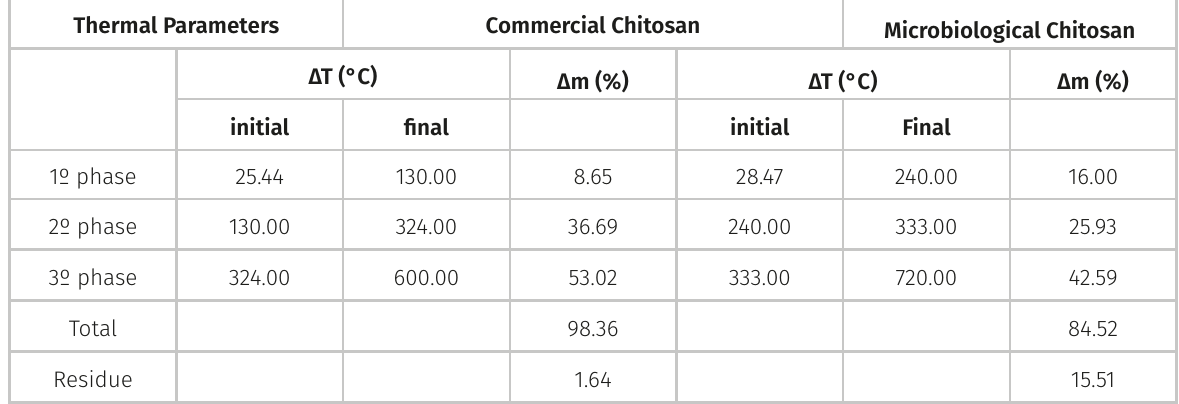
Table V. Thermal parameters of TGA and DSC analyses for evaluating microbiological and commercial chitosan. Thermal